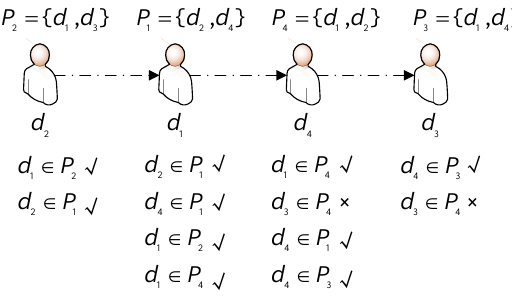
Figure 2. An example of sequence